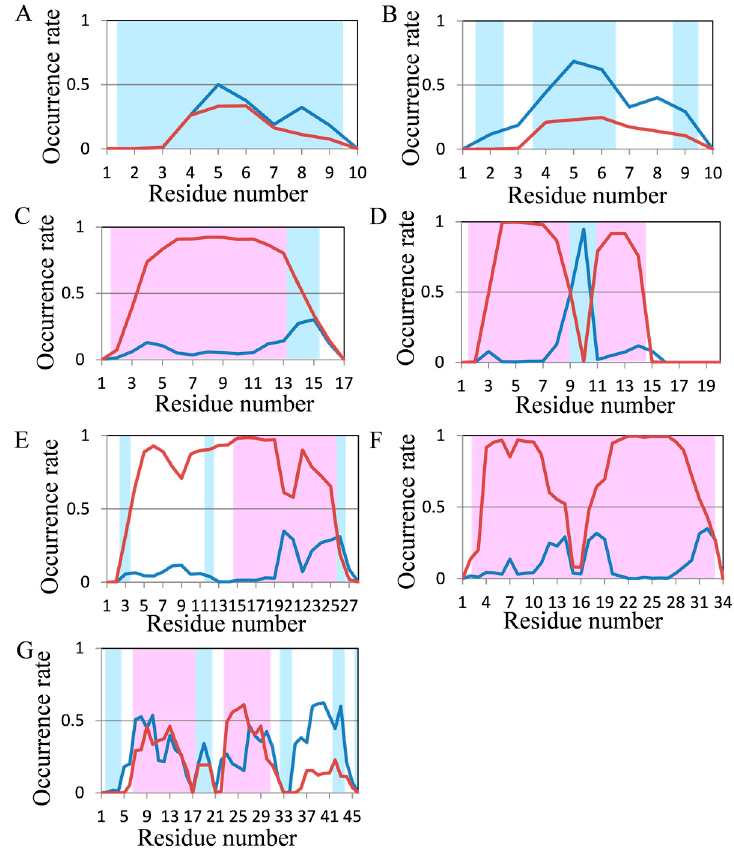
Figure 8. Analysis of the secondary structure formation in seven short proteins by REMD. The occurrence rate of secondary structures of ( A ) chignolin; ( B ) CLN025; ( C ) 2I9M; ( D ) Trp-cage; ( E ) FSD-1; ( F ) HPH and ( G ) crambin in REMD. Color coding is the same as that in Figure 3.